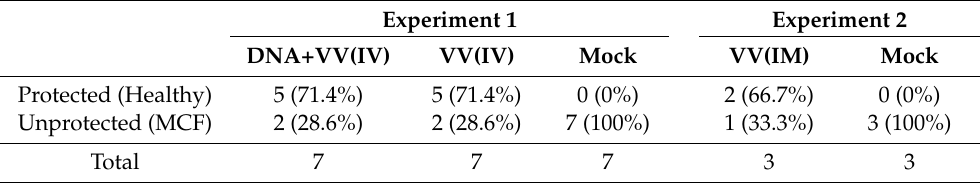
Table 2. Efficacy of OvHV-2-gB based vaccine candidates following OvHV-2 lethal challenge in a rabbit model. Experiment